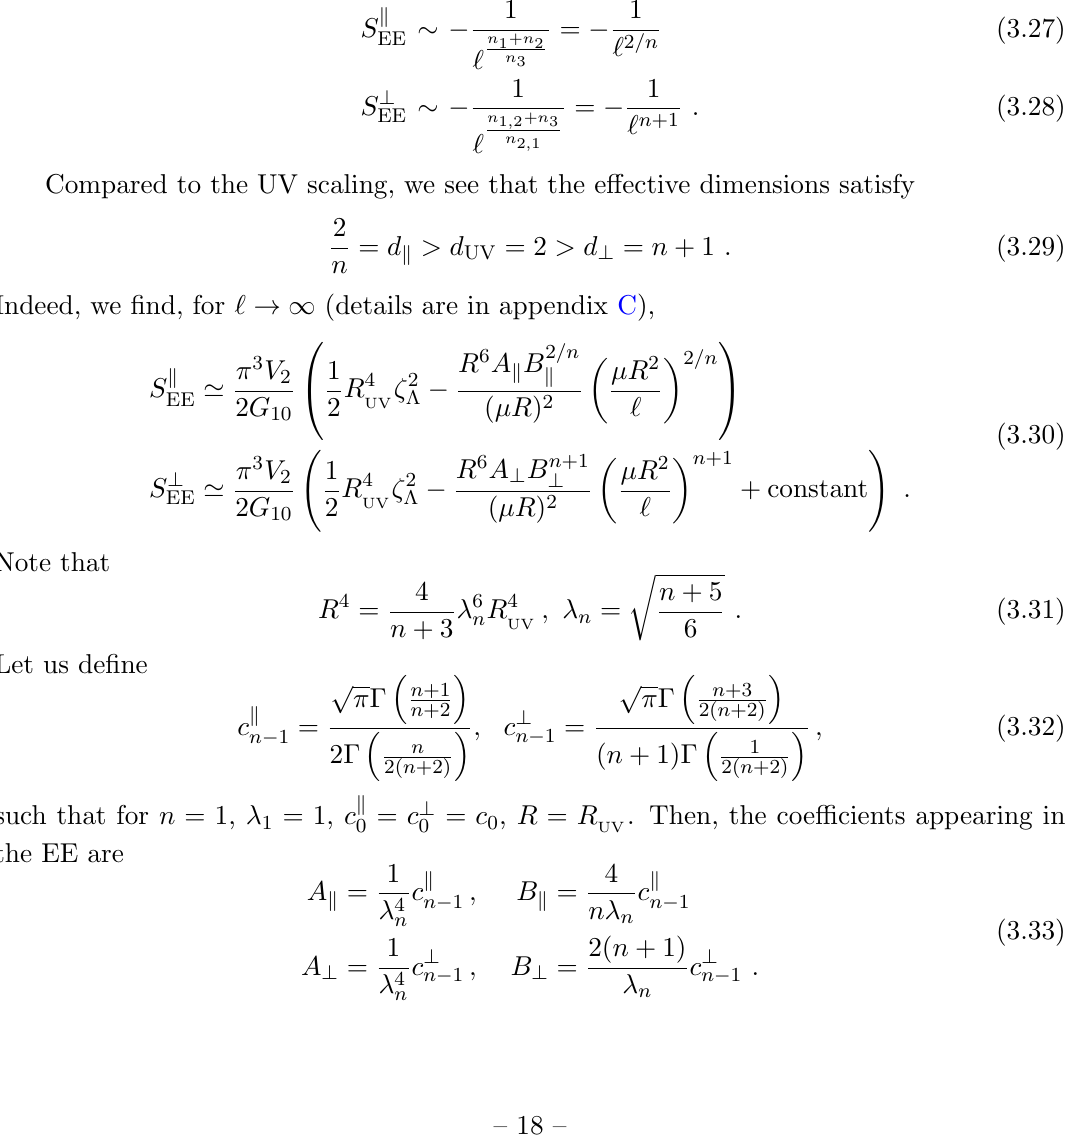
Figure 5 . The regularized entanglement entropies for the anisotropic Lifshitz solutions with m = 2 and n = 1 = 3 (blue), n = 1 = 2 (red), and n = 2 = 3 (black) and Q f = 1. Left: the in-plane case. The slopes are -2 in the UV and (cid:0) 2 =n is the IR conforming with (3.27). Right: the o(cid:11)-plane case. The slopes are -2 in the UV and (cid:0) ( n + 1) in the IR conforming with (3.28). n = n < 1. We then expect the dependence of the EE with the width of the strip to 3